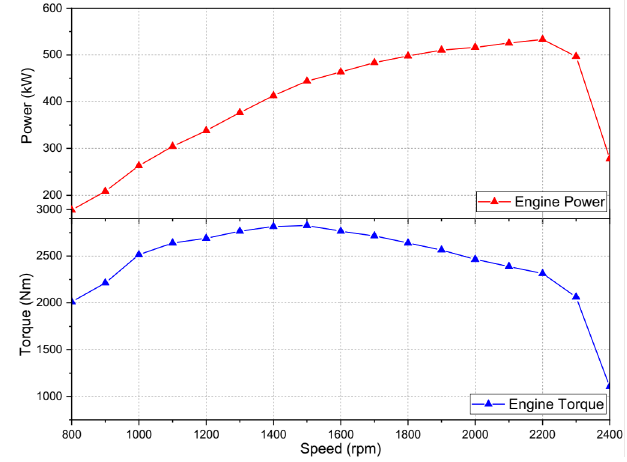
Figure 2. ICE output power and torque versus